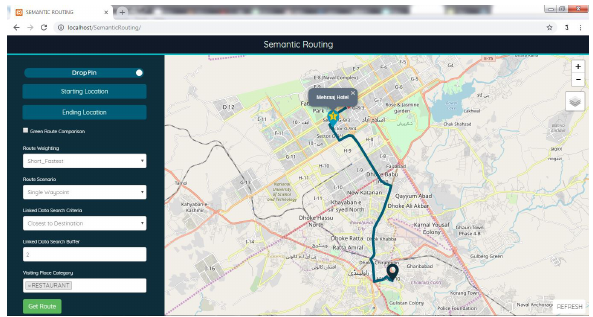
Figure 11. Routing through the waypoint closest to route destination